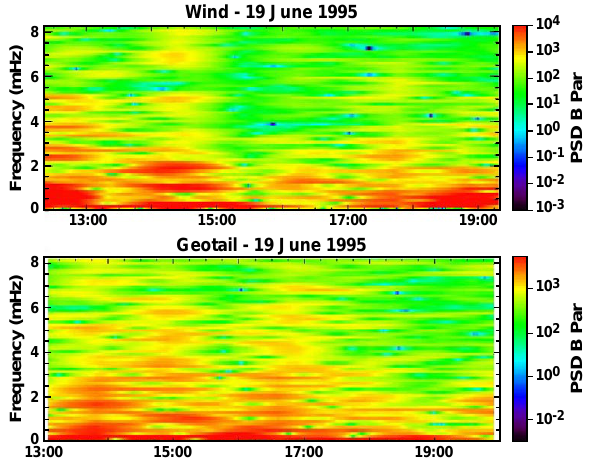
Fig. 9. Geotail data in the magnetosheath inside the compression region, 19 June 1995. Top panel: magnetic field and density; bot- tom three panels: field-aligned and perpendicular components of b and v .